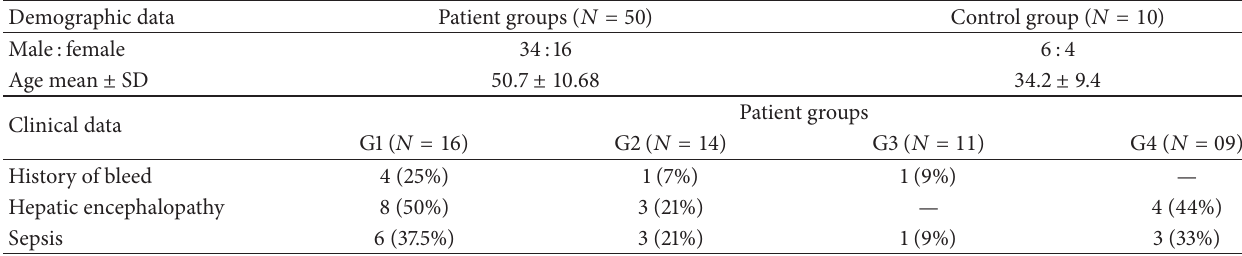
Table 1: Demographic and clinical